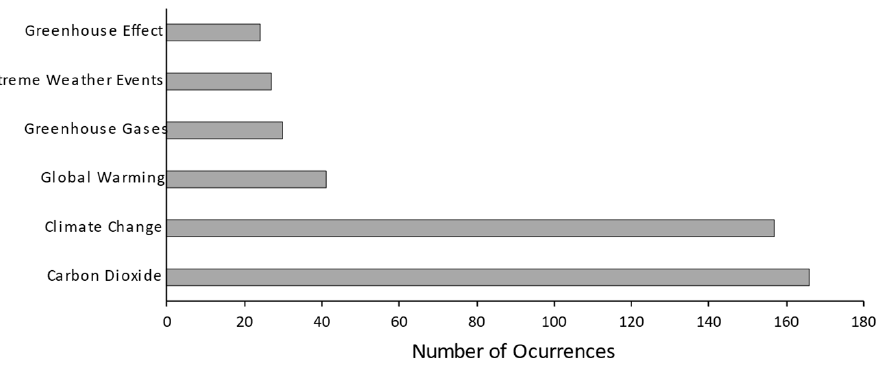
Figure 2. Most relevant keywords identified in the 282 documents identified in the SCOPUS search.